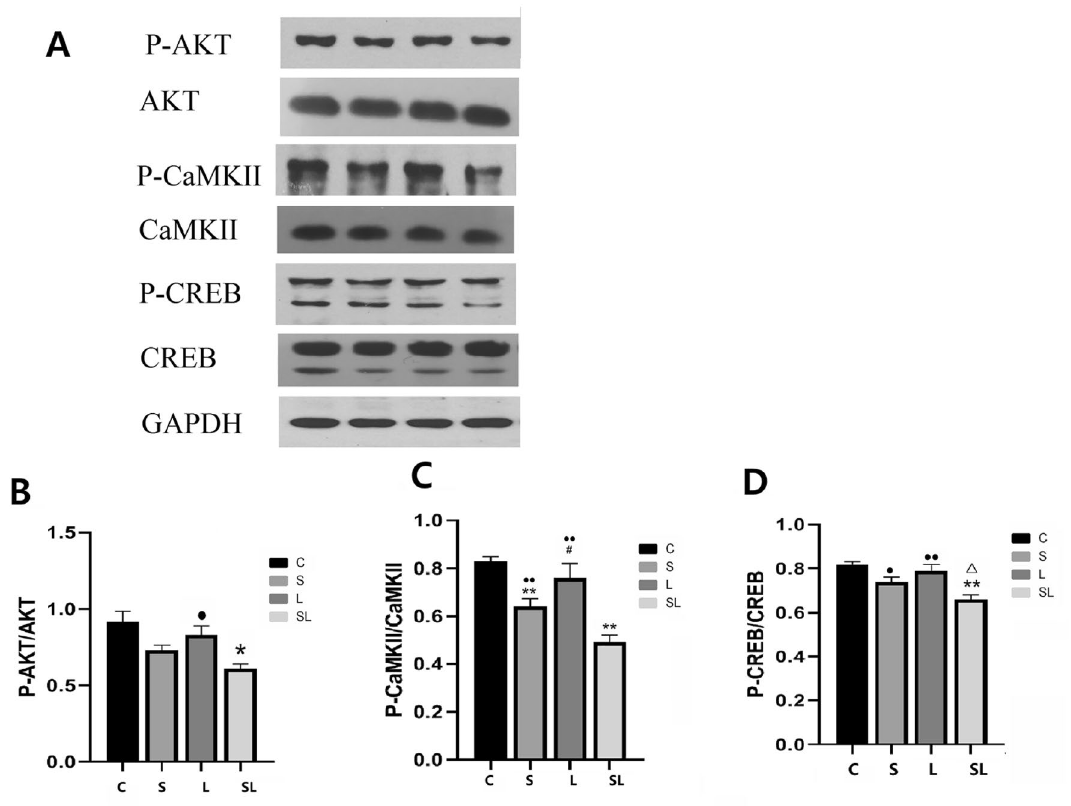
Figure 5. Comparisons of the levels of p-AKT ( B ), p-CaMKII ( C ), and p-CREB ( D ) in the hippocampi of the C, S, L and SL groups. ( A ) Expression of four proteins in the C, S, L and SL groups. ( B ) Statistical analysis results of p-AKT in the four groups. ( C ) Statistical analysis results of p-CaMKII in the four groups. ( D ) Statistical analysis results of p-CREB in the four groups. The data are presented as the means ± SDs. * p < 0.05 and ** p < 0.01 compared to the C group. # p < 0.05 compared to the S10 group. • p < 0.05 and •• p < 0.01 compared to the cumulative group. Δ p < 0.05 indicates the existence of interaction effects between the 2.856 GHz and 1.5 GHz microwaves. “C” stands for the control group, “S” stands for the 2.856 GHz microwave exposure group, “L” stands for the 1.5 GHz microwave exposure group, and “SL” stands for the 2.856 and 1.5 GHz cumulative exposure